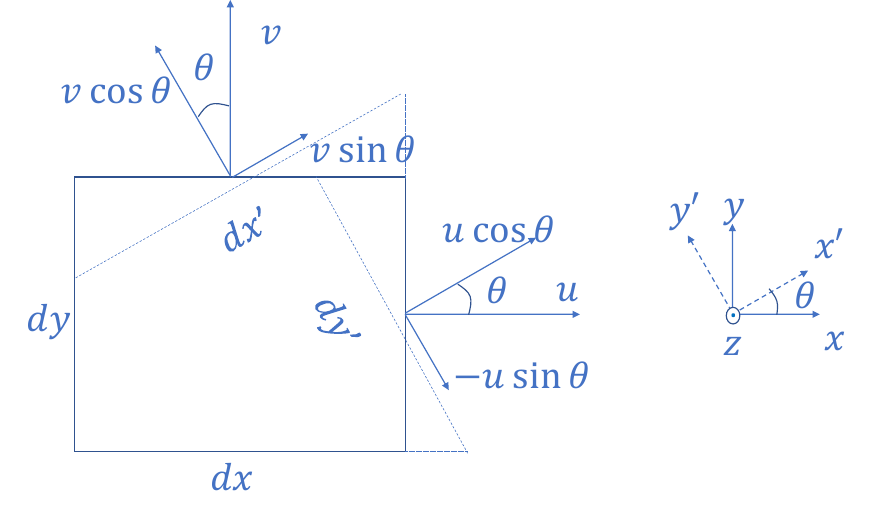
Figure A3. Strain vector components expressed with principal and non-principal axis coordinate